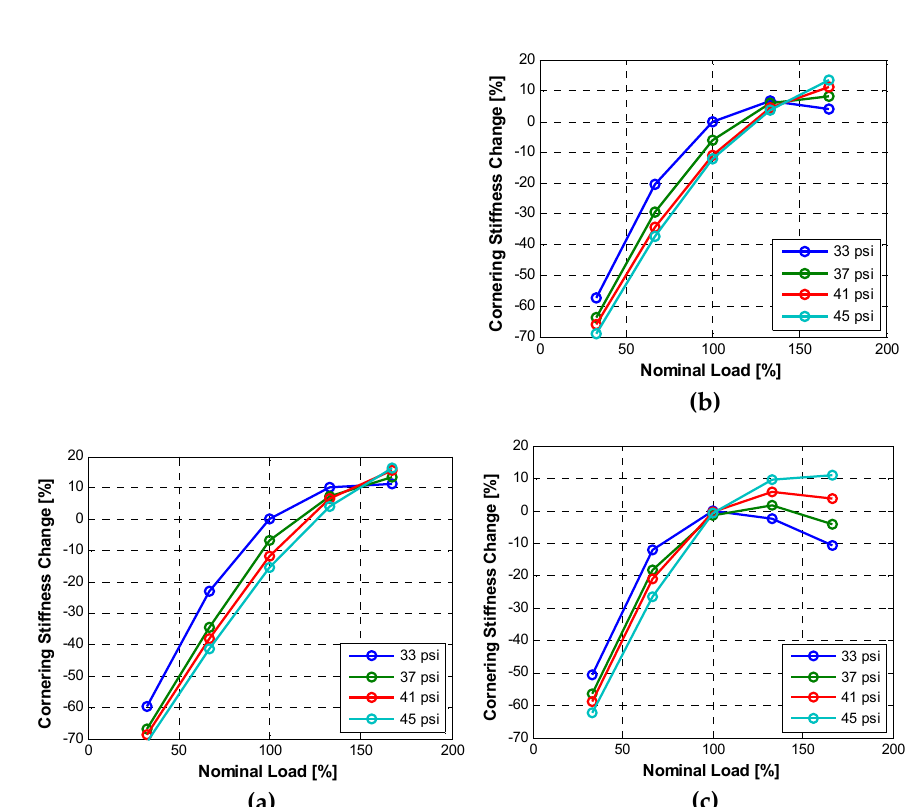
Figure 10. Cornering stiffness versus inflation pressure—influence of tire tread depth. ( a ) Full tread depth, ( b ) 60% tread depth, ( c ) 30% tread depth.